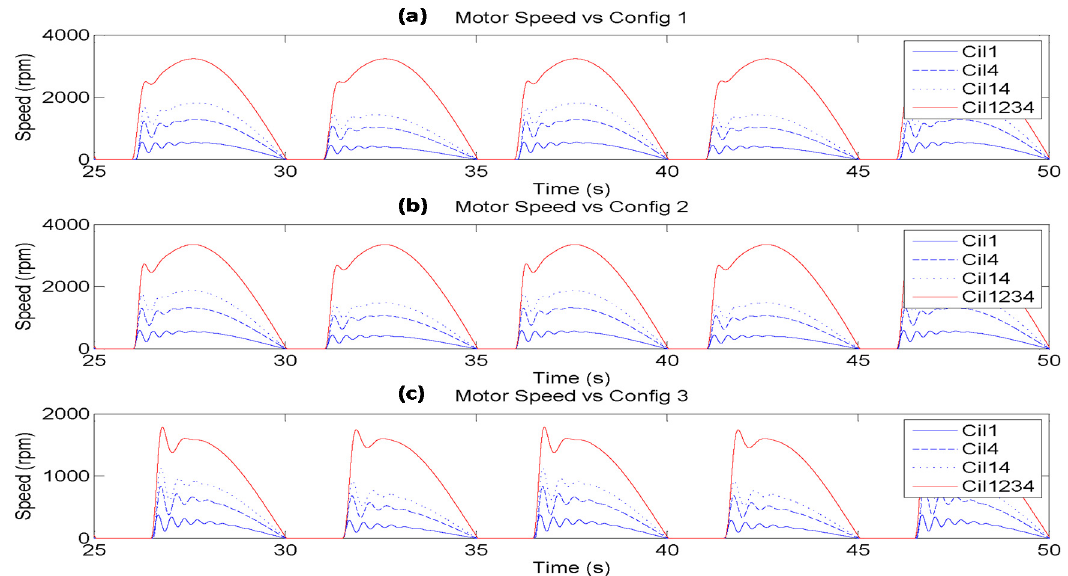
Figure 11. Instantaneous hydraulic motor speed versus activated cylinders using different configurations: Config 1 ( a ), Config 2 ( b ) and Config 3 ( c